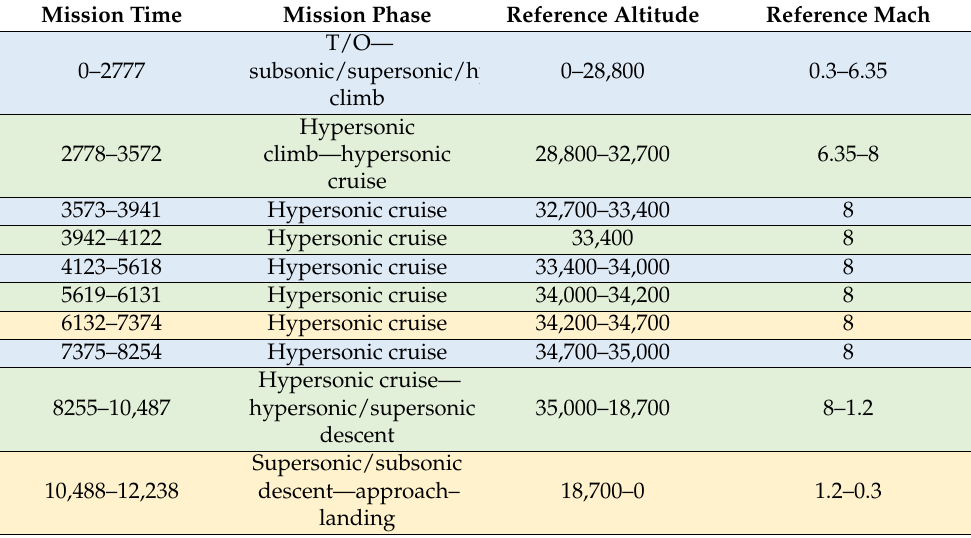
Table 2. Reference phases in which the different modules are active (green for module 1, yellow for module 2 and blue for module